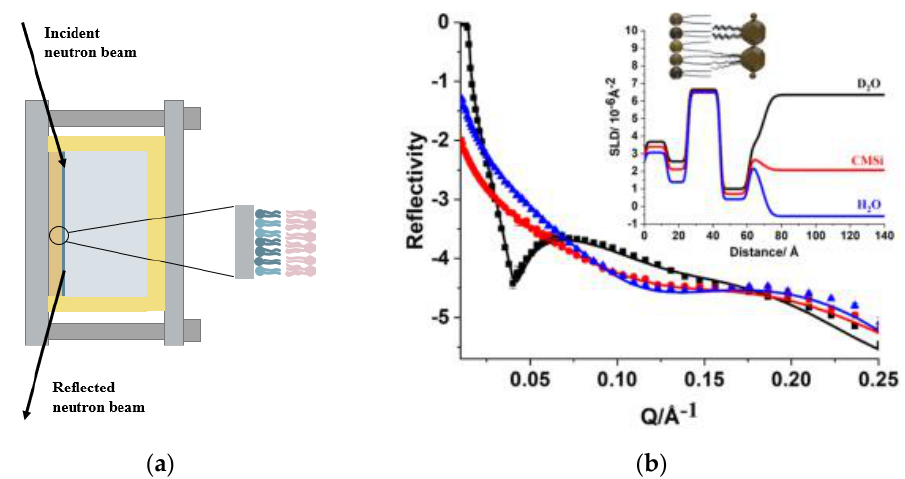
Figure 7. ( a ) A schematic representation of the NR method. ( b ) The NR profiles with the corresponding SLD graphs (top right corner) under D 2 O (black) CMSi (red) and H 2 O (blue) contrasts. The NR technique was conducted on a model Gram-negative bacterial outer membrane of d − DPPC (inner leaflet)/ lipid A (outer leaflet) on the SiO 2 surface. The model membrane was characterized in three isotopic contrasts, i.e., in D 2 O, CMSi (contrast-matched silicon), and H 2 O buffers. Adapted with permission from [48] under the Creative Commons Attribution 4.0 license (https://creativecommons.org/licenses/by/4.0/ (accessed on 30 May 2022)).